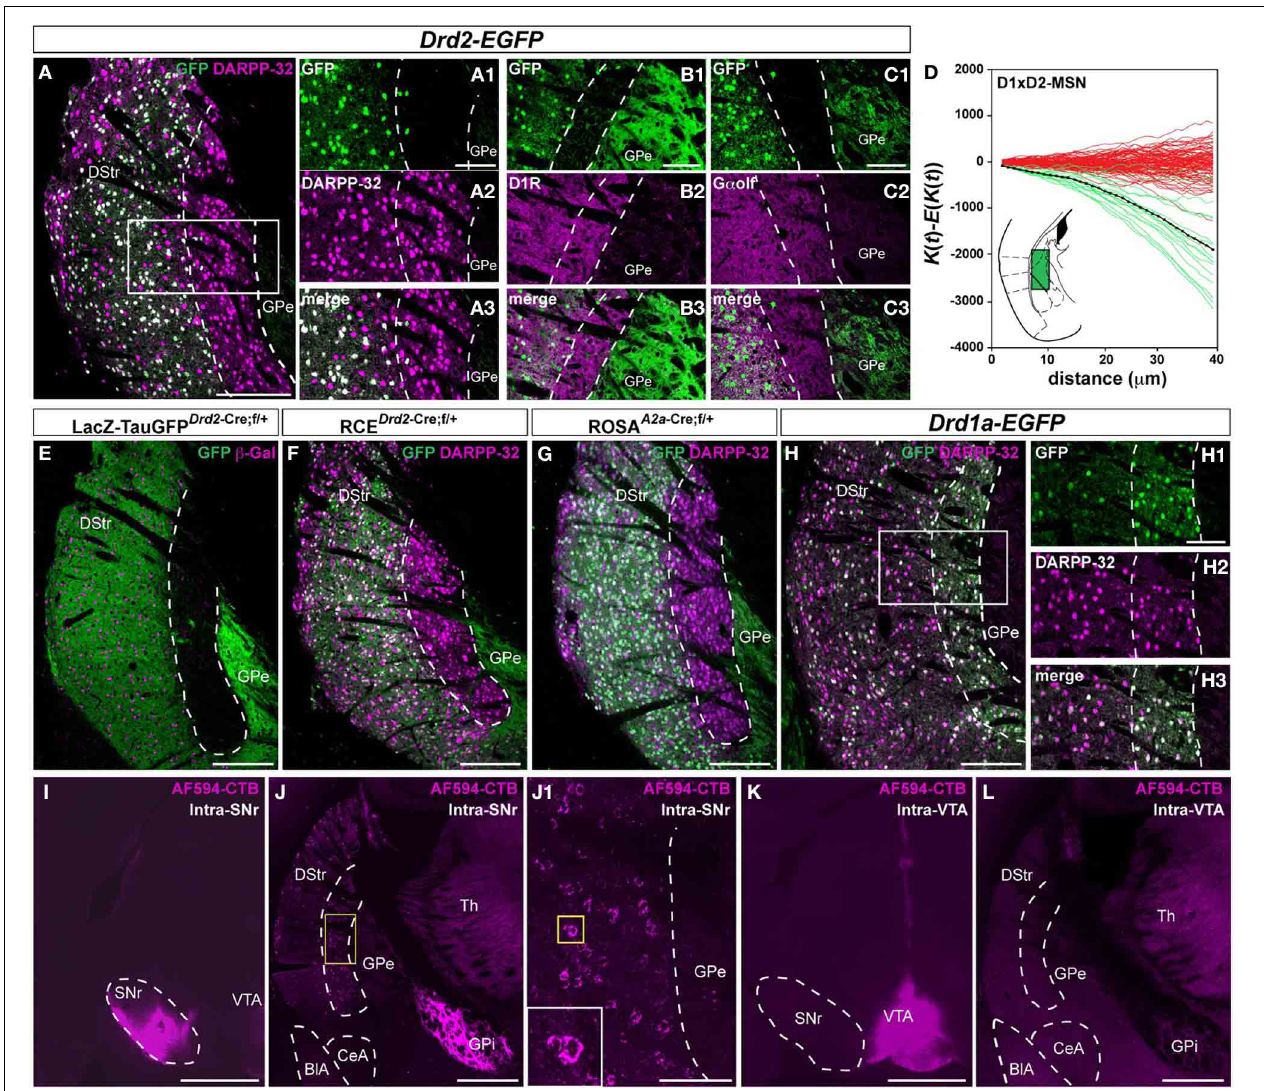
FIGURE 3 | Segregated distribution of D1R- and D2R/A2aR-expressing MSNs in the caudal part of the striatum. (A) DARPP-32 (magenta) and GFP (green) immunofluorescence in the caudal part of the dorsal striatum of Drd2-EGFP mice ( n = 10). Scale bar, 200 μ m. High magnification of the area delineated by the white rectangle (GFP, A 1 ; DARPP-32, A 2 ; merge A 3 ). Scale bar, 100 μ m. Note the absence of D2R-expressing MSNs in a longitudinal stripe bordering the GPe. (B,C) Striatal sections from Drd2-EGFP mice ( n = 5) stained with antibodies against D1R (GFP, B 1 ; D1R, B 2 ; merge, B 3 ) and G α olf (GFP, C 1 ; DARPP-32, C 2 ; merge C 3 ). Scale bar, 100 μ m. (D) Analysis of Ripley’s K -function for D1R-MSNs (GFP-negative) and D2R-MSNs (GFP-positive) distributions (green lines) with the average (black line) compared to simulated distributions following CSR (red lines). For the experimental data (green lines) the difference between the estimated K -function and the expected K -function ( ∧ K ( t ) − E [ ∧ K ( t )]) is negative indicating that the D1R- and D2R-MSNs occupy different parts of the sample area; in addition the distribution of the green lines does not overlap with the distribution of the simulated data (red lines) indicating a non-random distribution of D1R-MSNs and D2R-MSNs with respect to each other. Because of the non-random distribution, only the spatial relation between D1R- and D2R-positive MSNs (D1xD2) was evaluated. Inset, schematic illustration of the areas analyzed. (E,F) Pattern of Cre-mediated recombination